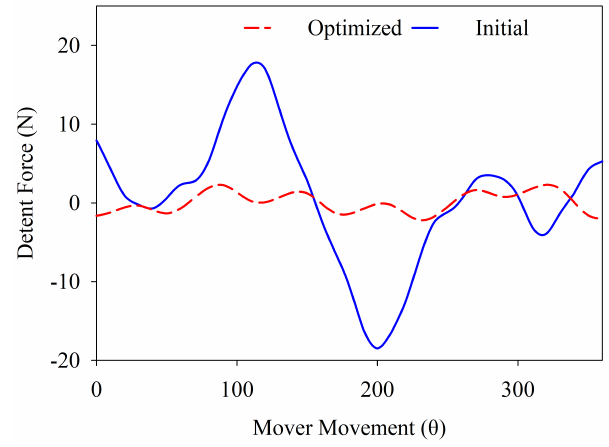
Figure 15. Detent force of the proposed single-sided VFPMLM.